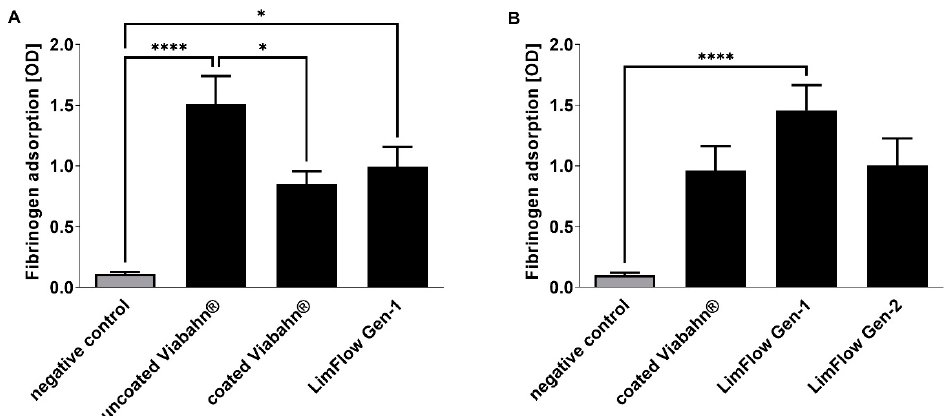
Figure 2. Analysis of fibrinogen adsorption to the graft surfaces. Detection of adsorbed fibrinogen in ( A ) experiment series B and ( B ) experiment series C. The data are shown as mean + SD. Statistical analysis was performed using the Friedman test followed by Dunn’s multiple comparison test. n = 8, (* p < 0.05, **** p < 0.0001).